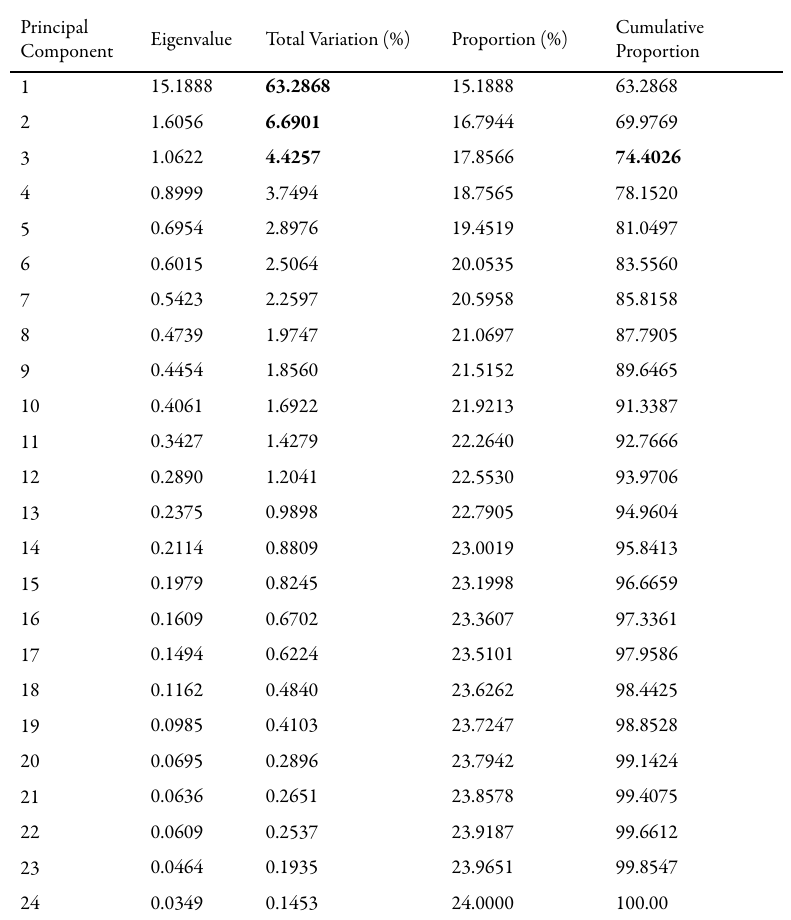
Table 1 - Eigenvalues, Total Variation (%), Proportion (%) and Cumulative Proportion of the 24 variables obtained with principal component analysis of Tetrapedia diversipes wings in the areas studied, Bahia of Reconcavo region,